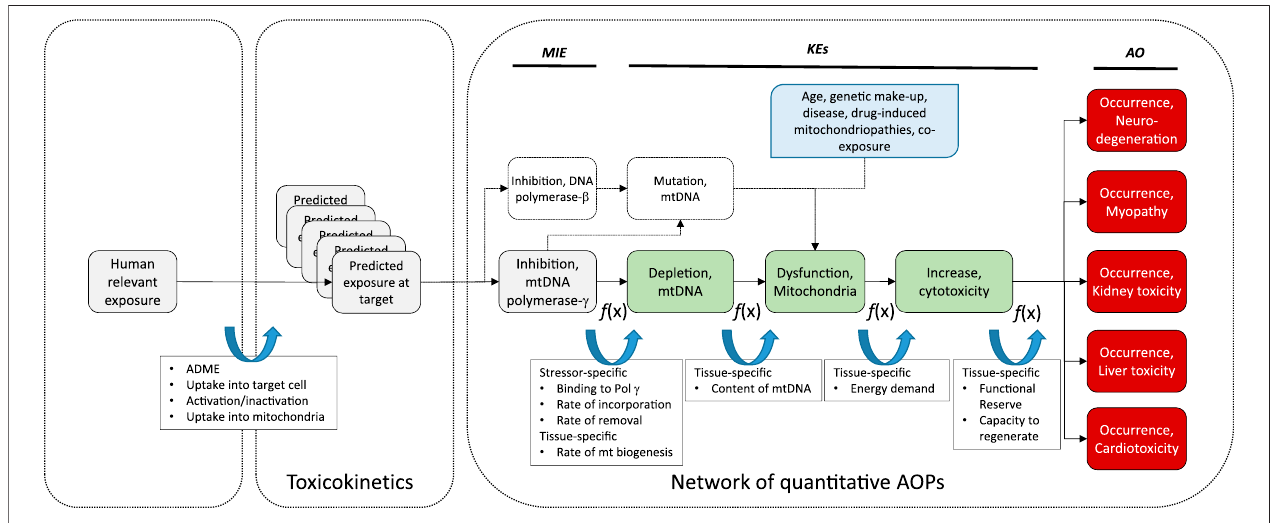
FIGURE3 | Schematic presentation ofauniversalAOPofPol γ inhibition leadingto adverse outcomesin kidney and extrarenal tissues, with predicted exposure at target site, feed-forward and feedback mechanisms, and potential modulating factors as determinants of the tissue-speci fi c biological response to a chemical stressor.